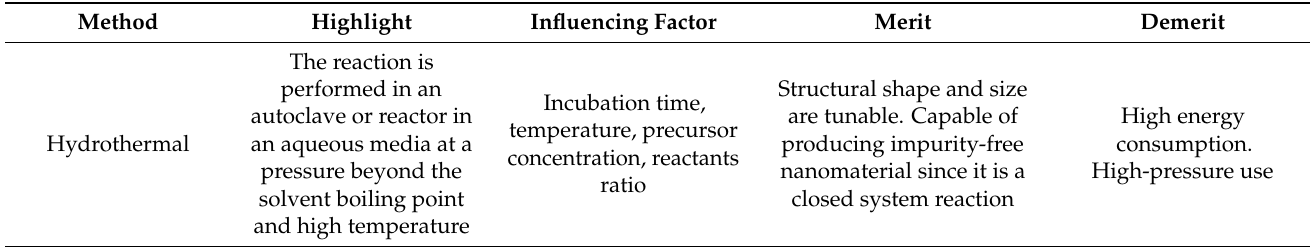
Table 4. Various methods are employed for the synthesis of metal oxide